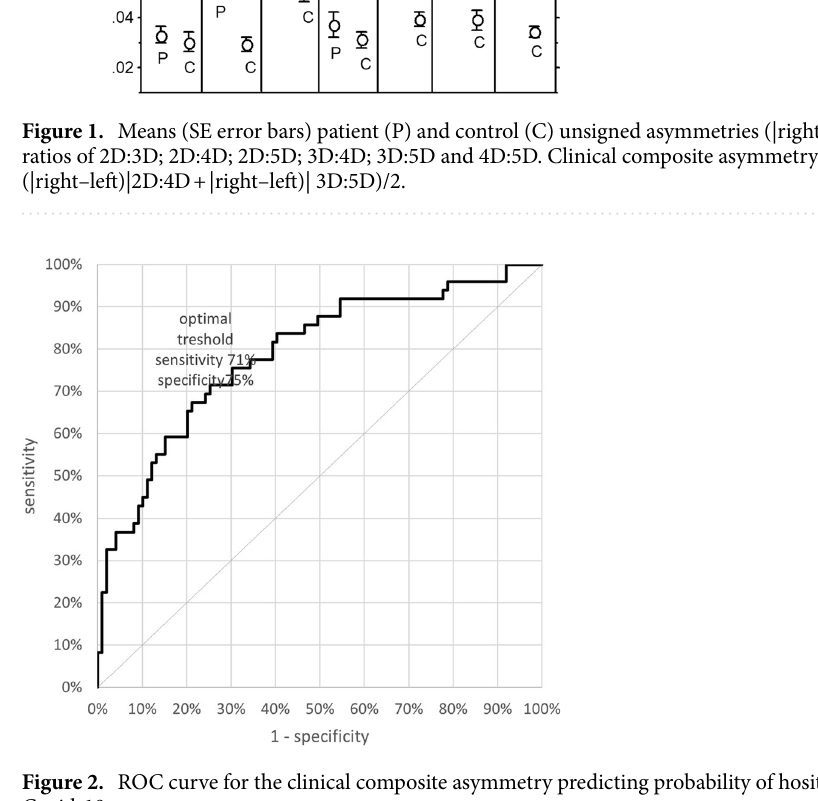
Figure 2. ROC curve for the clinical composite asymmetry predicting probability of hositalization due to